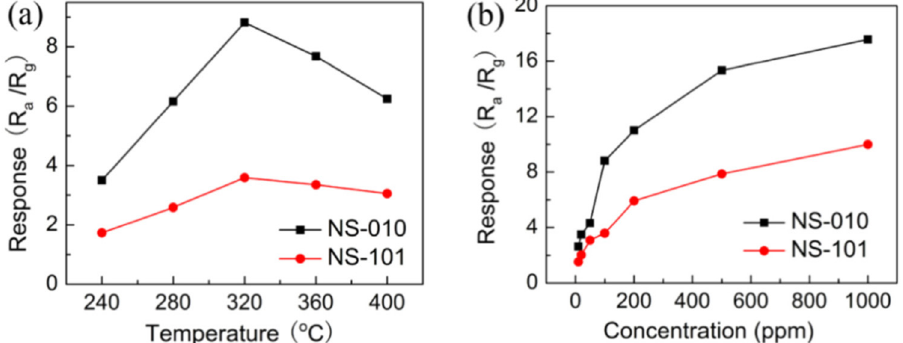
Figure 7. Resistive sensor response for anatase films containing crystallites with (010) and (101) surfaces ( a ) at 100 ppm acetone concentration and different sensor temperature, and ( b ) at 320 °C and different acetone concentration. Reproduced from Reference [67] with permission; copyright (2018) Elsevier.